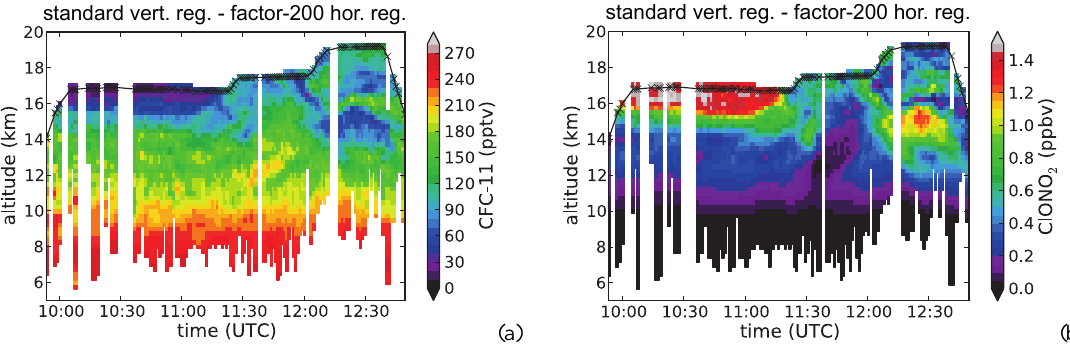
Fig. 3. Two cross-sections of CFC-11 (a) and ClONO 2 (b) volume mixing ratios with standard vertical regularisation and factor-200 hori- zontal regularisation. standard vert. reg. - factor-2000 hor. reg.